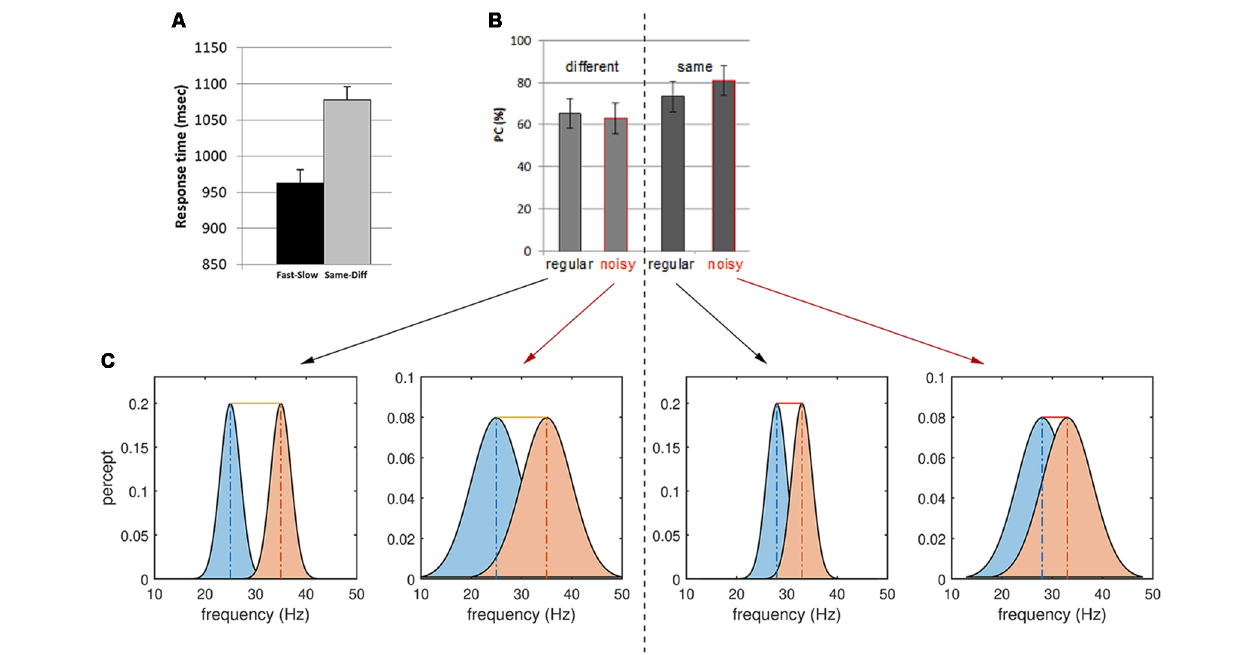
FIGURE 3 | Behavioral results for the same-different context and interpretations. (A) Reaction time for Fast-Slow vs. Same-Different comparisons. Note the longer reaction times for the latter task. (B) Proportion of correct (PC) responses (or accuracy) of regular and noisy response for different and same trials in the Same-Different task. (C) Stimulus noise increases the variance of the perceptual representation of the two frequencies f1 and f2, increasing the overlap between them. A larger overlap between perceptual representations decreases the sensitivity of responses to Different trials (left). The yellow bar depicts the difference between the mean of the two percepts—here the sum of the true stimulus differences and the perceptual error. Conversely, noise increases the accuracy of responses to Same trials (right): some slight difference in perception occurs even for identical, periodic stimuli (red bars, sum of perceptual errors). However, stimulus noise degrades the precision of each percept, hence increasing their overlap and masking these small (false) perceptual differences.